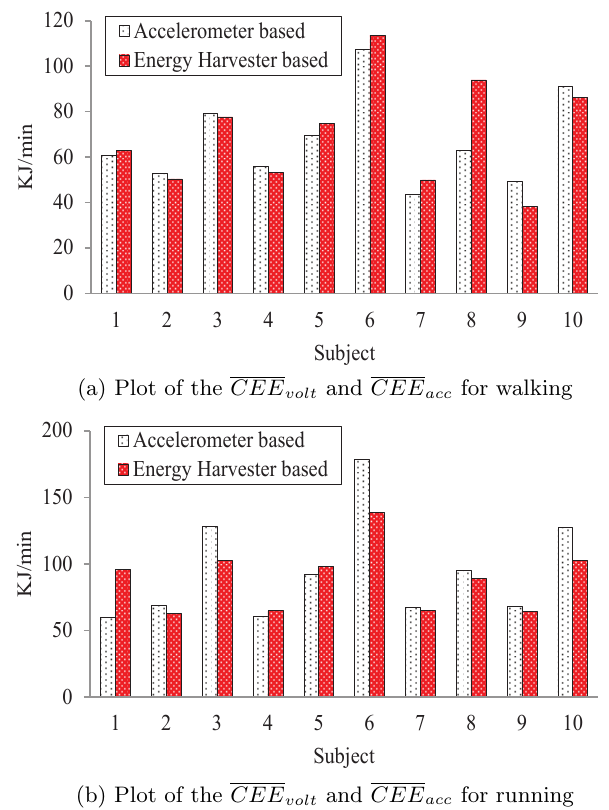
Figure 9: The average CEE per second of the ACC- based and proposed PEH-based